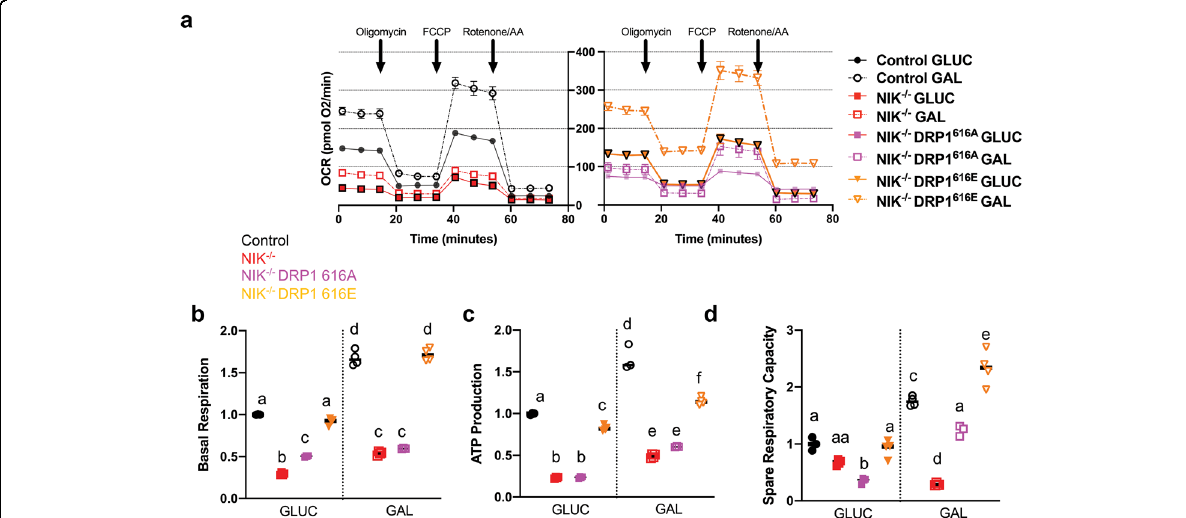
Fig. 7 Constitutively active DRP1-S616E restores oxidative metabolism of NIK-de fi cient GBM cells. a Oxygen consumption rate was determined using the Seahorse Mito Stress test with control and NIK − / − cells (see Figs. 2b, 4a, b), as well as NIK − / − cells ectopically expressing DRP1- S616E that were cultured in 18 mM glucose (GLUC) or 18 mM galactose (GAL) media. Data depict the mean of ≥ 3 replicates per each cell type. b – d Individual mitochondrial function parameters were calculated from the data shown in a and shown as fold change compared to control cells in GLUC. b Basal respiration. Different letters indicate statistical signi fi cance using one-way ANOVA with Tukey post-hoc test. All comparisons have p < 0.0001. c ATP production. All statistical comparisons have p < 0.0001 except “ a vs f ” ( p < 0.001). d Spare respiratory capacity. All statistical comparisons have p < 0.0001 except “ a vs aa ” (ns), “ aa vs b ” ( p < 0.001), “ aa vs d ” ( p < 0.05) “ a vs c ” ( p < 0.001), and “ c vs e ” ( p <